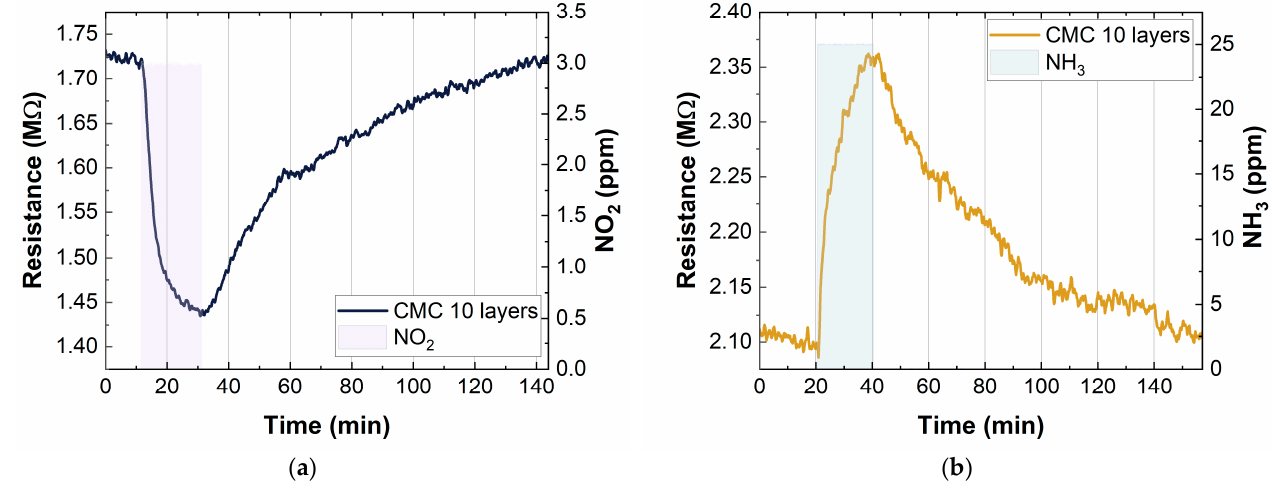
Figure 8. Example of resistance change in CMC-SWCNT-based (p-type semiconductors) gas sensors to ( a ) 3 ppm NO 2 and ( b ) 25 ppm NH